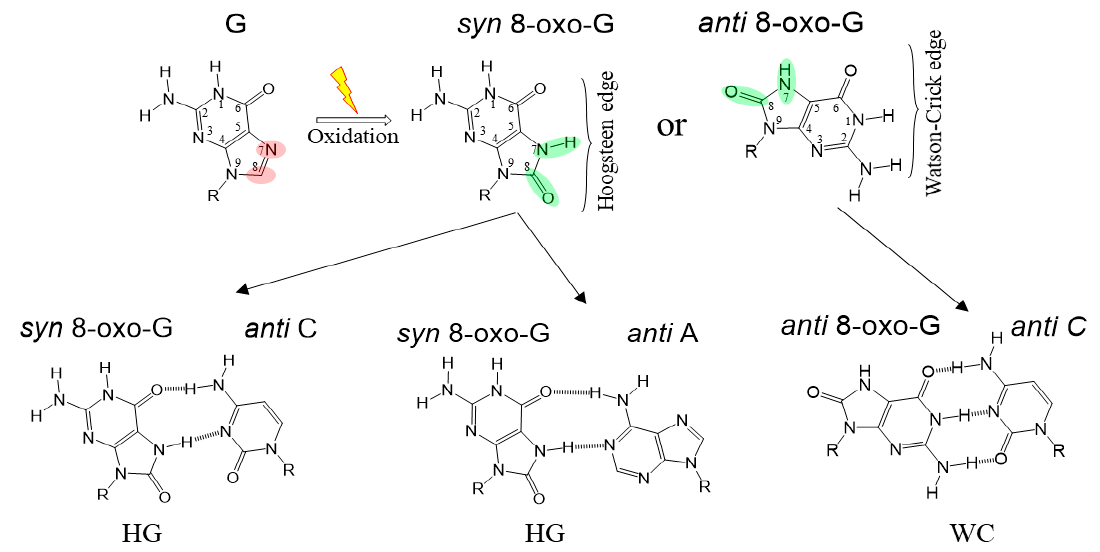
Figure 1. Structure of oxoG and formation of Watson–Crick (WC) and Hoogsteen (HG) base pairs with A and C nucleobases. Red and green circles represent the sites of modification before and after oxidation, respectively. Brackets indicate the edge of oxoG which is exposed for H-bonding in syn or anti conformation. Dashed lines show H-bonds.